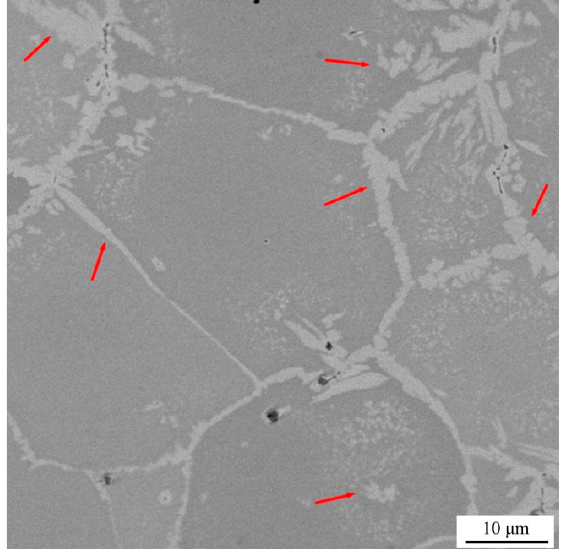
Figure 1. Microstructure of the as-cast Al 10 Cr 30 Fe 25 Mn 30 Ti 5 HEA. Red arrows label some examples of the secondary phases present in the alloy. Table 2. Average composition (at.%) of the as-cast Al 10 Cr 30 Fe 25 Mn 30 Ti 5 HEA and compositions of the matrix and secondary phase particles.